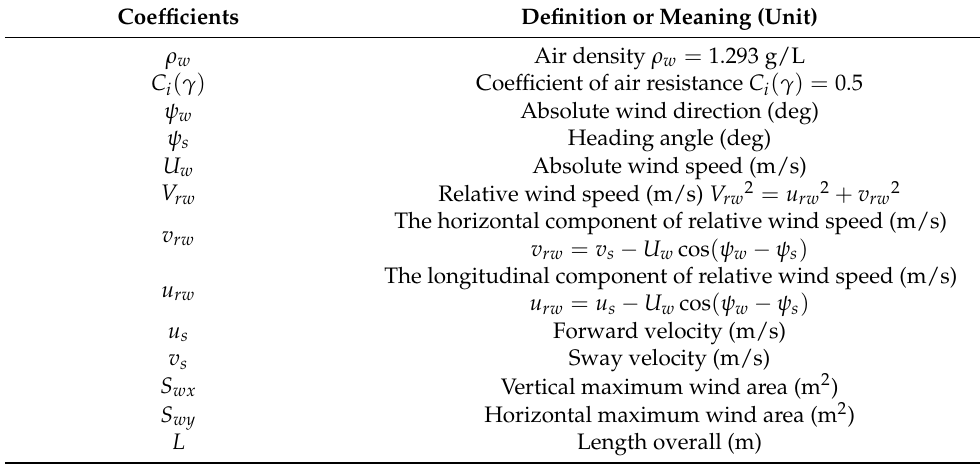
Table 3. Correlation coefficients of the Bernoulli equation.